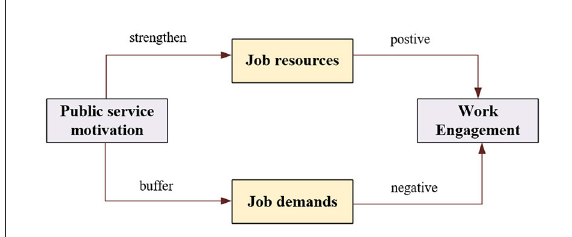
FIGURE1 The complete JD-R model of the relationship between public service motivation and work engagement (public service motivation can strengthen the positive effect between work resources and engagement, while buffering the adverse effects between work demands and work